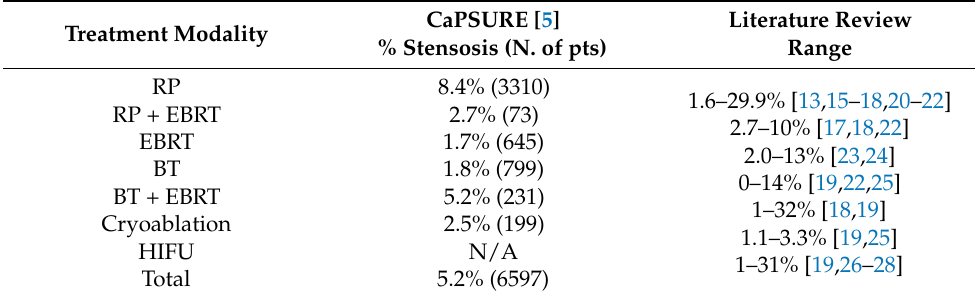
Table 2. Incidence of posterior urethral obstruction following primary treatment of